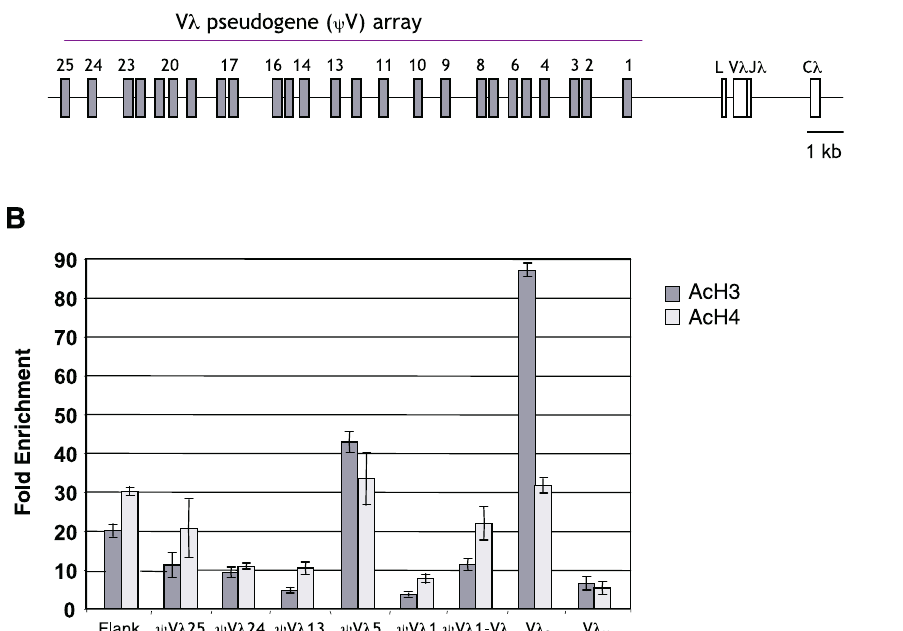
Figure 1. Chromatin Modification at the DT40 Ig k Locus (A) Schematic diagram of the rearranged chicken Ig k locus, showing the 25 w V k regions and the rearranged V k R gene. C k , constant region; L, leader; V k J k , variable region. (B) Summary of a representative chromatin immunoprecipitation experiment, assaying N-terminal acetylation of histones H3 and H4 (AcH3 and AcH4). Sites interrogated were as follows: a region approximately 1 kb upstream of the w V k array (flank), w V k 25, w V k 24, w V k 13, w V k 5, w V k 1, the region between w V k 1 and V k , and the rearranged V k R and unrearranged V k U alleles. See Materials and Methods for details. Bars indicate standard deviation. doi:10.1371/journal.pbio.0050246.g001 PLoS Biology |